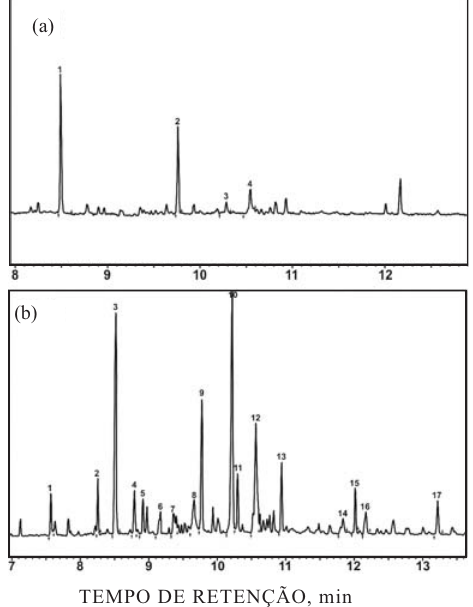
Figura 2. Cromatograma dos compostos orgânicos da subfração alifática presentes na humina extraída de amostras de solo degradado pela extração de argila, com vegetação espontânea [ Brachiaria mutica (Forsk.) Stapf] (A) e em área com Acacia mangium Willd (B).